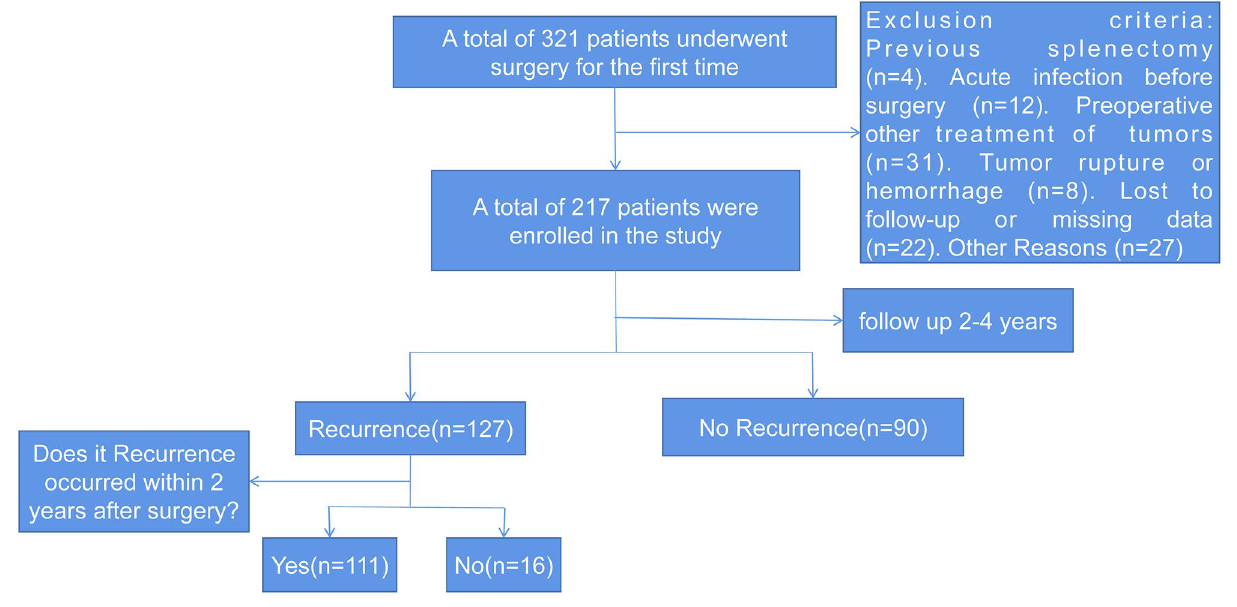
Figure 1. Flow chart for screening